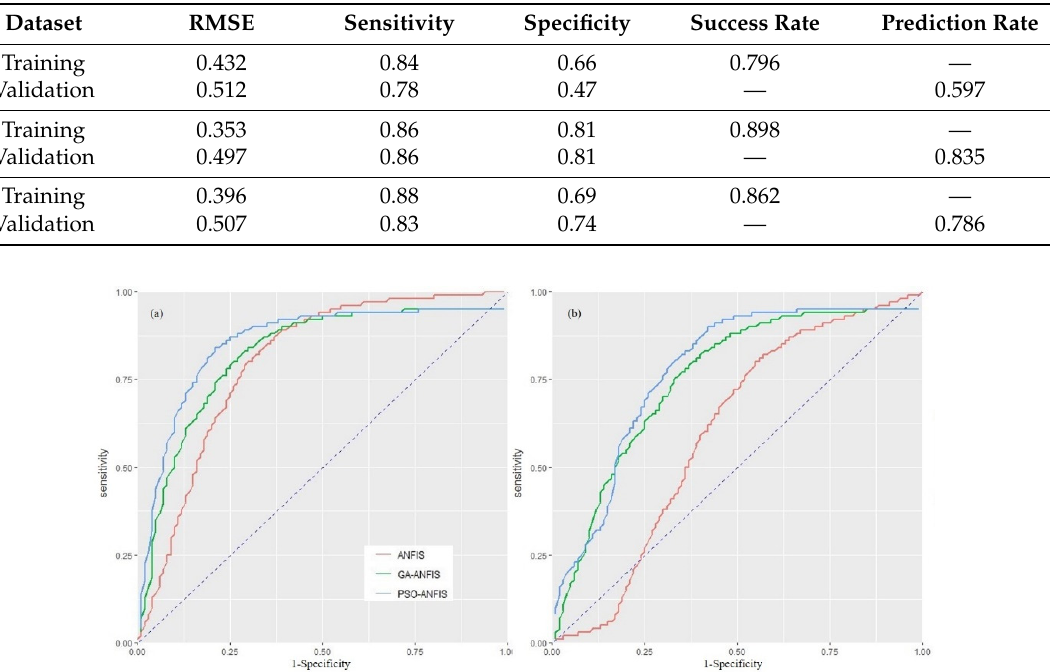
Figure 5. Convergence curve of the fitness function (RMSE) for PSO ‐ ANFIS and GA ‐ ANFIS in case of 1000 iterations.